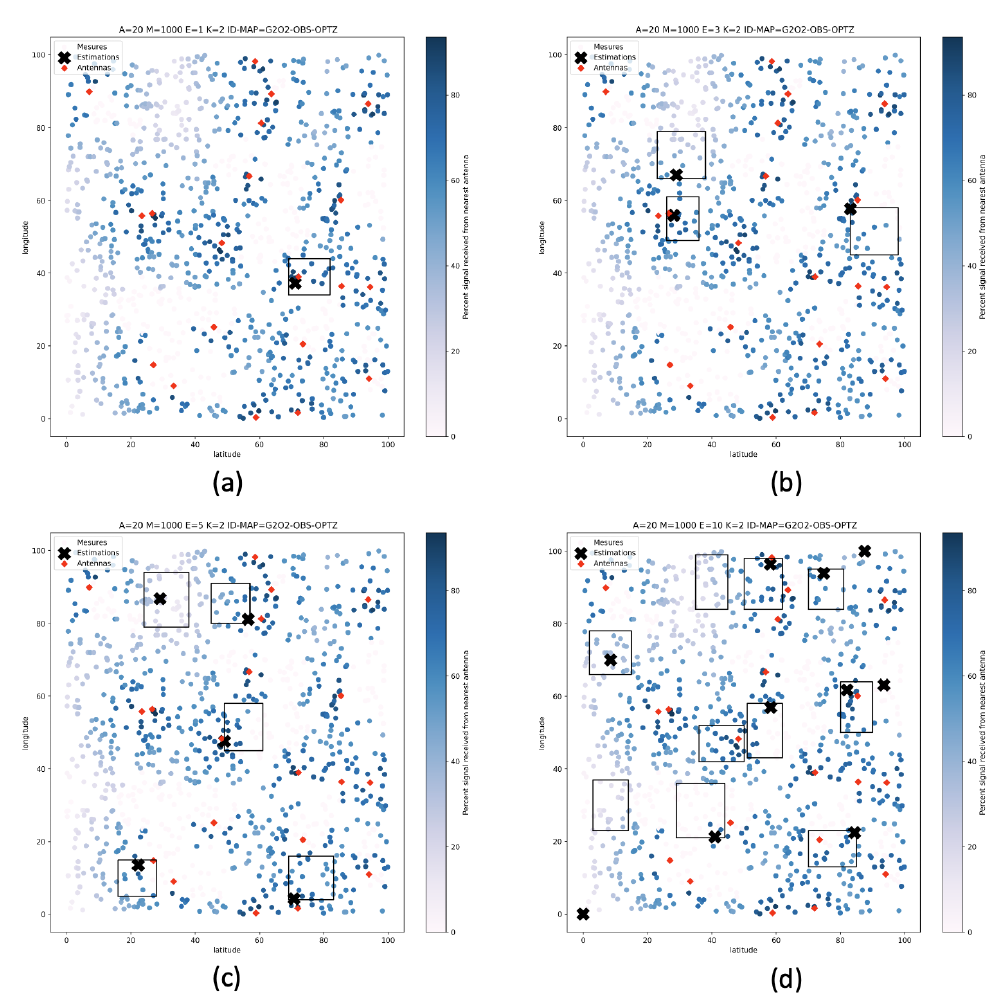
Figure 17. Proposed deployments after 200 iterations on 1, 3, 5, and 10 areas of interest with many obstacles ( a ) 1 area of interest, ( b ) 3 areas of interest, ( c ) 5 areas of interest, ( d ) 10 areas of